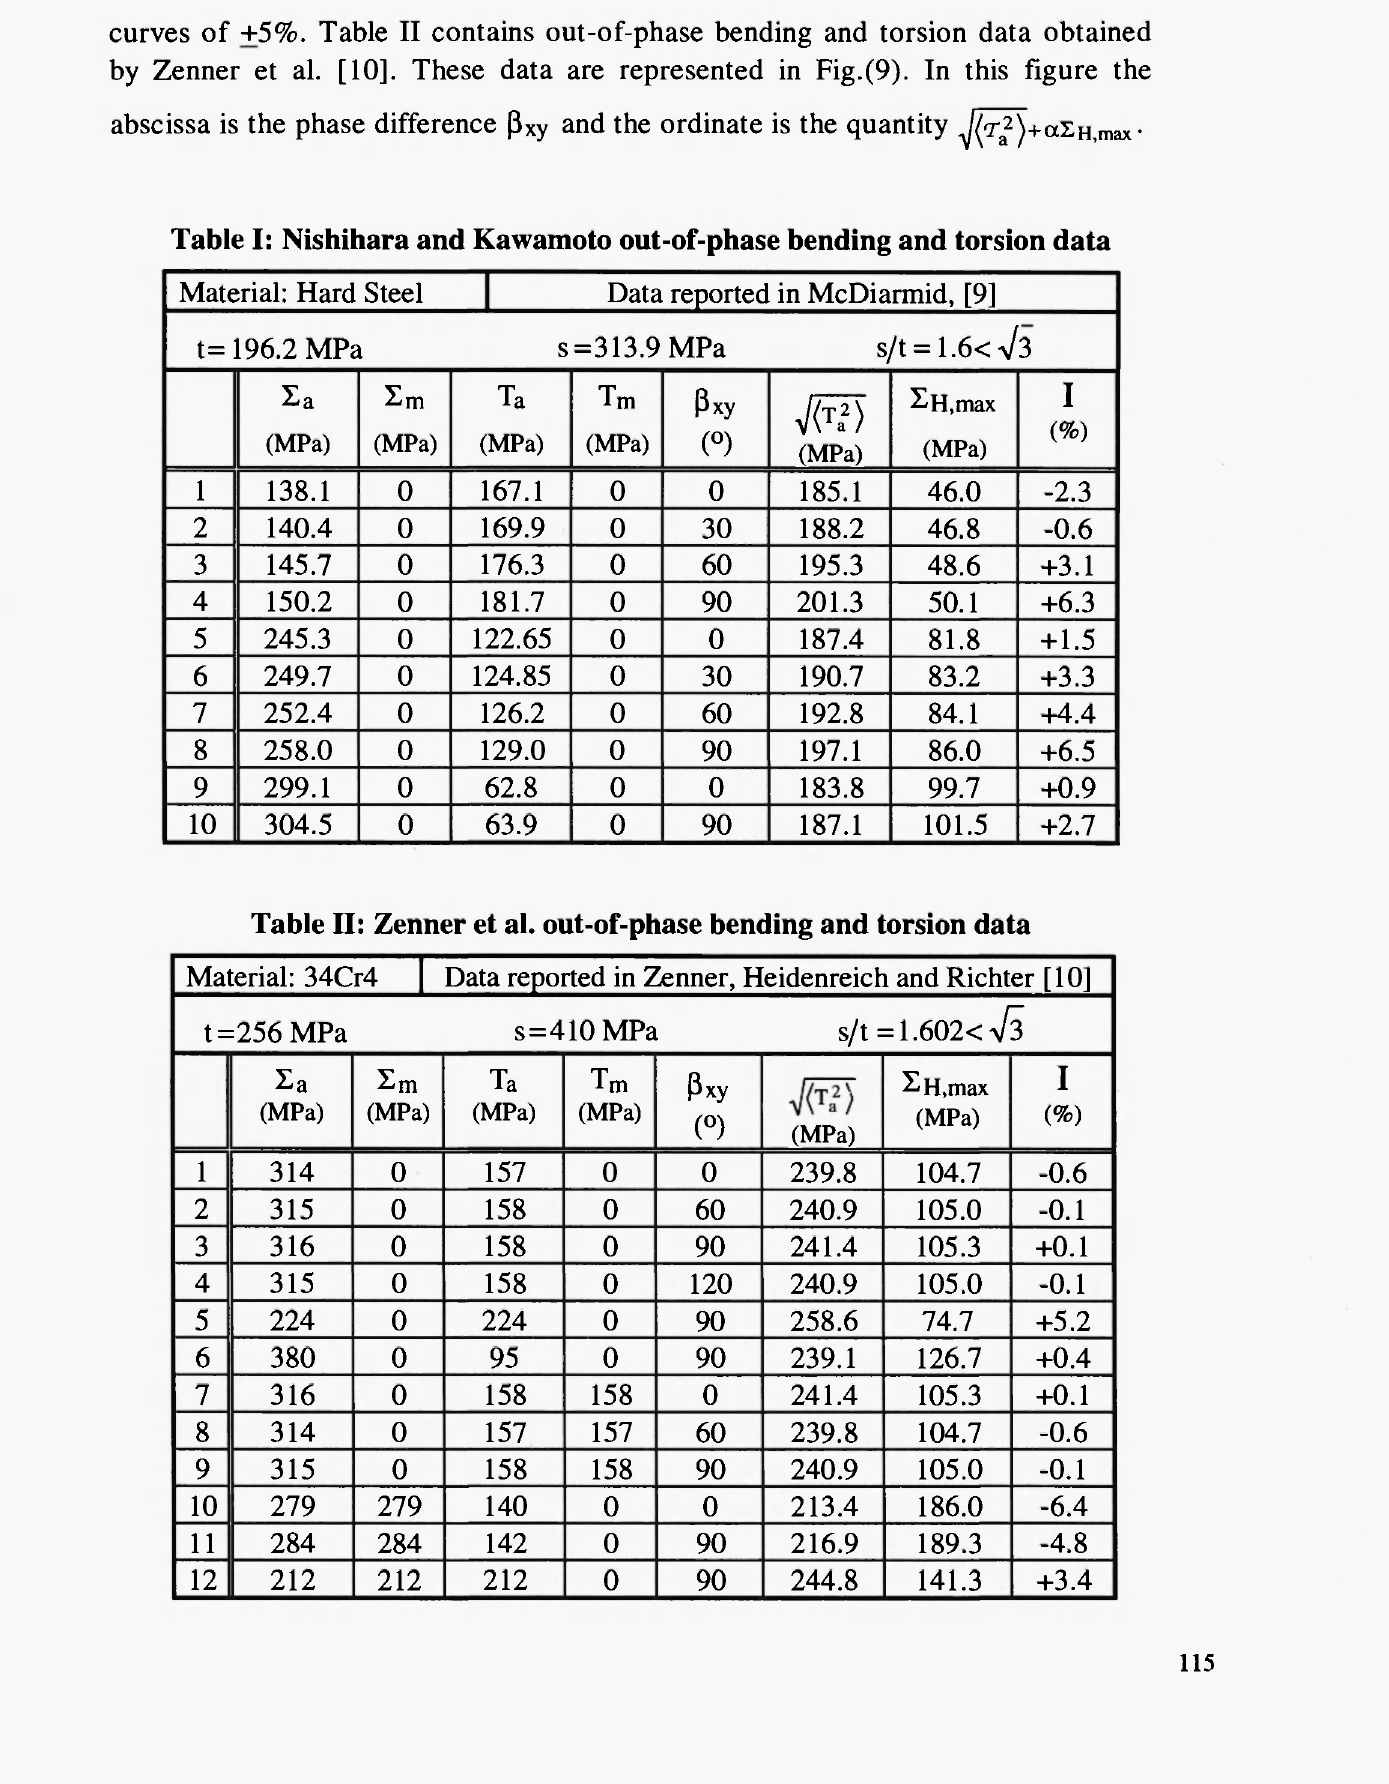
Table I: Nishihara and Kawamoto out-of-phase bending and torsion data Material: Hard Steel